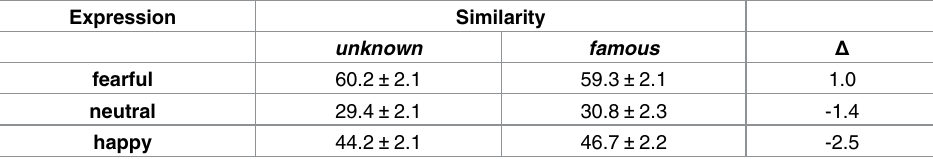
Table 3. Mean ratings of arousal (Exp. II).